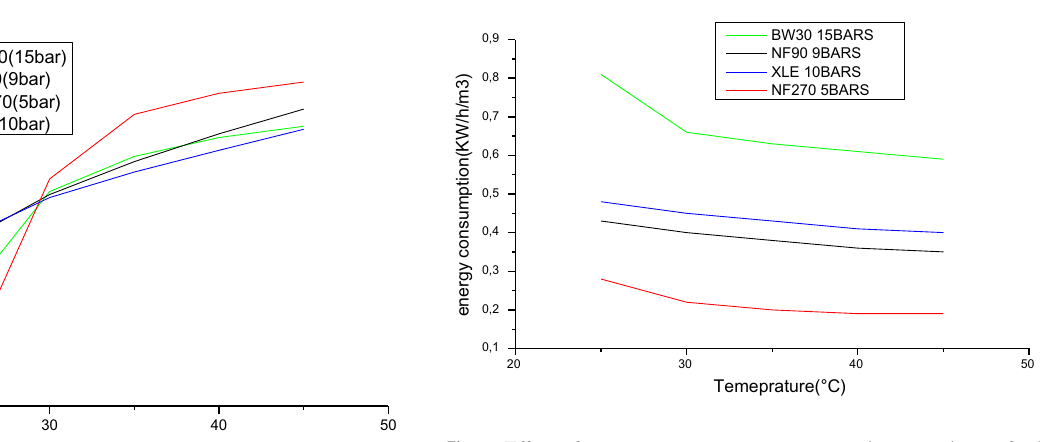
Fig. 7 Effect of temperature on energy consumption at optimum feed pressure for conf b